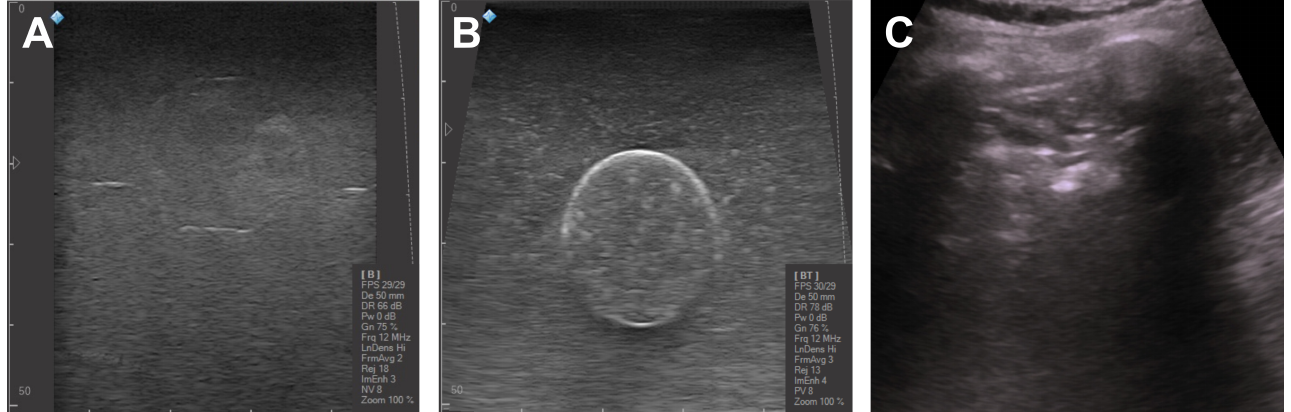
Figure 5. US images of solid inclusions embedded in the PVA-C phantom ( A , B ) as well as a real lung ultrasound ( C ). These PVA-C solid inclusions mimic the healthy parenchyma and demonstrate the flexibility of the fabrication: ( A ) with an irregular shape (10% PVA-C and 1% cellulose) and ( B ) with a spherical shape (12.5% PVA-C and 2% cellulose). ( C ) Lung ultrasound of a subject exhibiting a consolidation caused by pneumonia. The details of the acquisition for image ( C ) can be found in